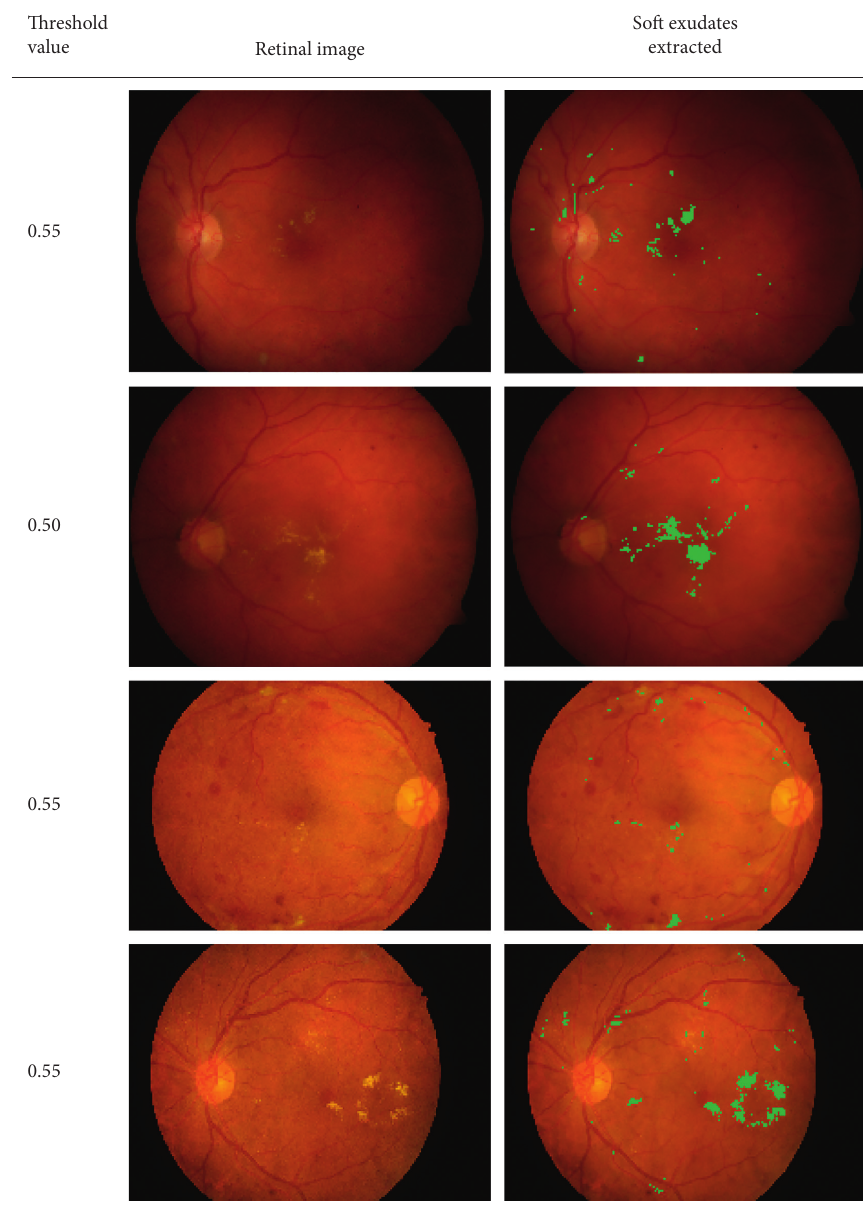
Figure 5: Segmented exudates and their respective threshold